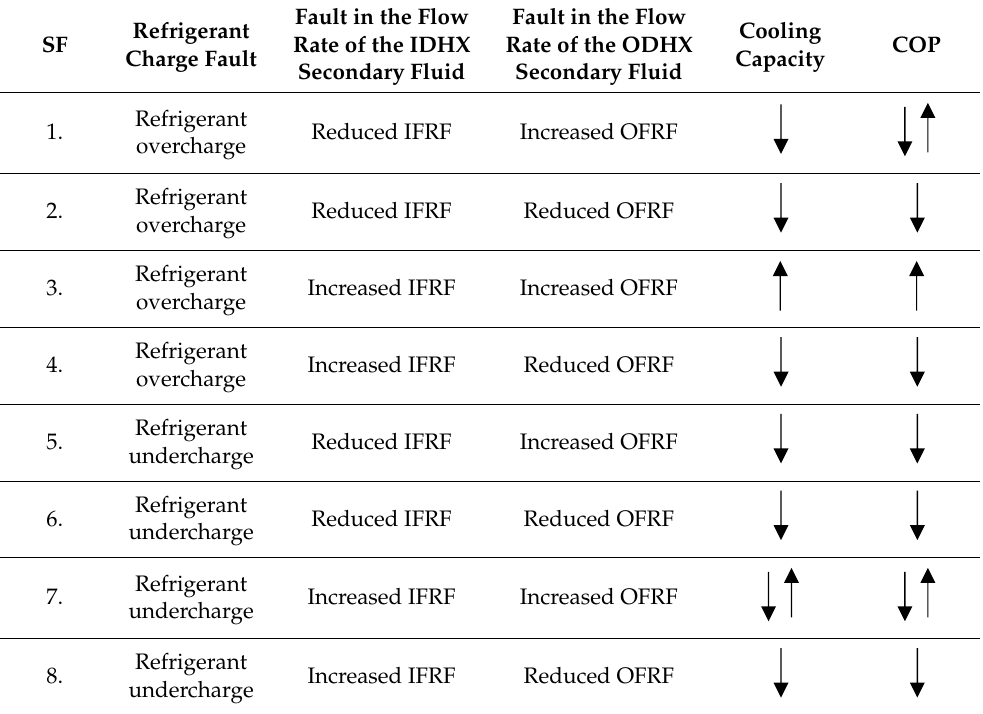
Table 3. Simultaneous faults in refrigerant charge and flow rate of secondary fluid of outdoor heat exchanger and indoor heat exchanger.